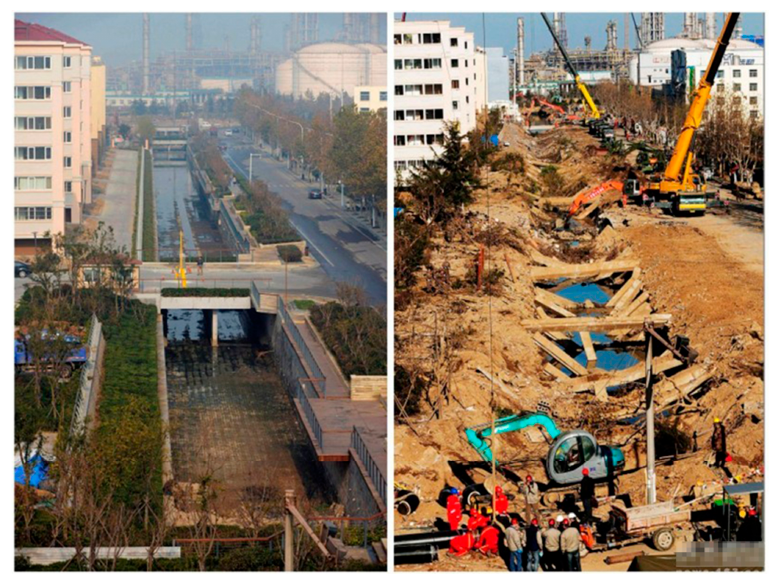
Figure 5. Compared accident scenes of the present (left) and past (right).